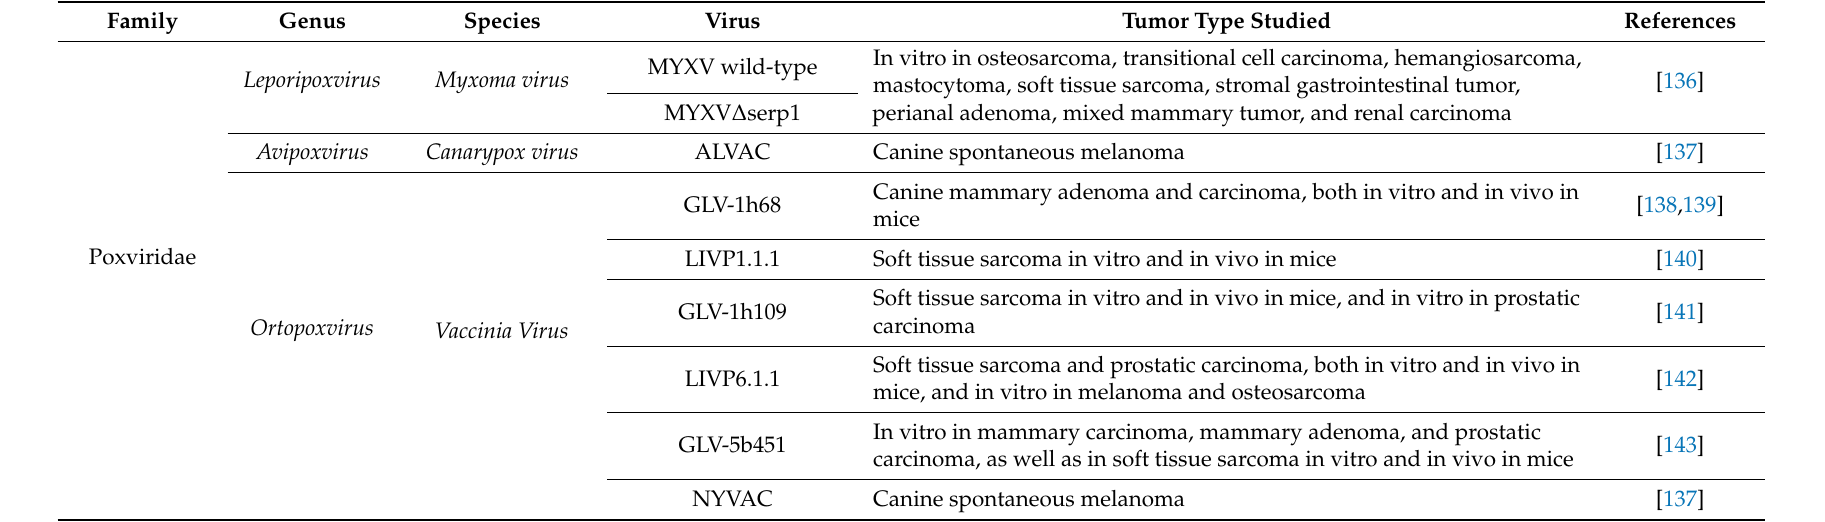
Table 2. Poxviruses studied in canine